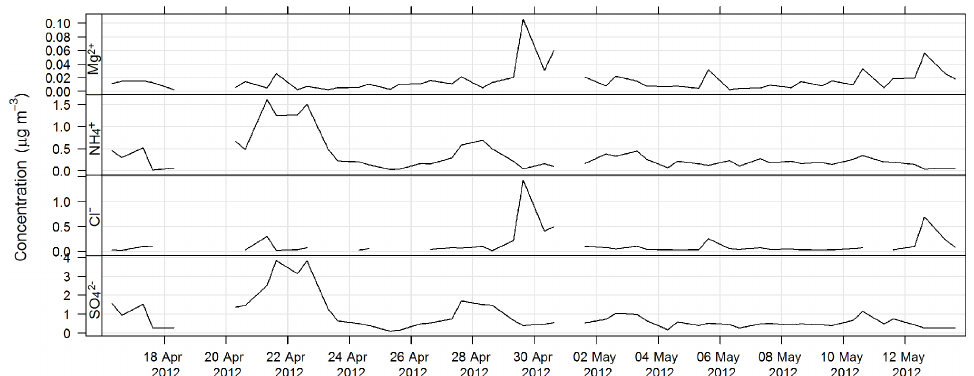
+ , and SO 2 − during SPS-II in 4 4